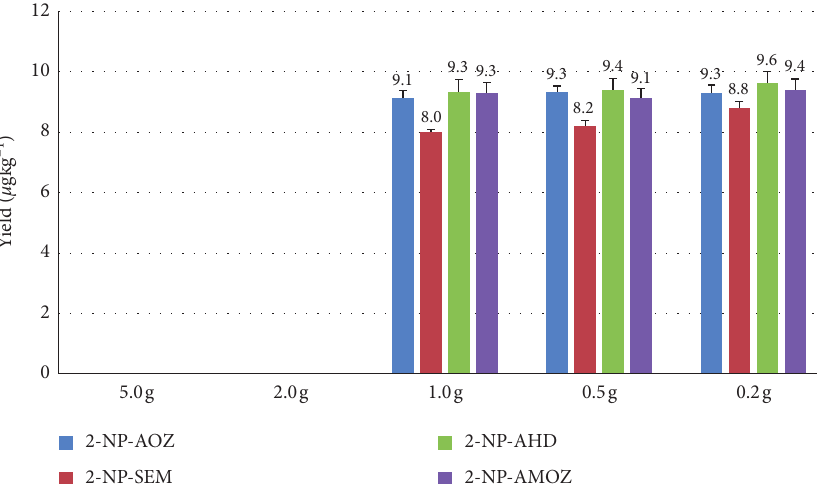
Figure 1: Optimization of sample weight of SSTP obtained by spiking a standard solution with each compound at a concentration of 10 μ gkg − 1 . Data are presented as mean ± SD ( n � 3; P < 0 . 05).